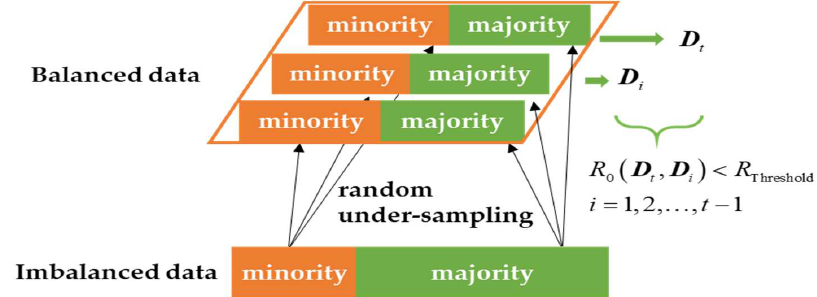
Figure 2. Schematic diagram of random under-sampling.